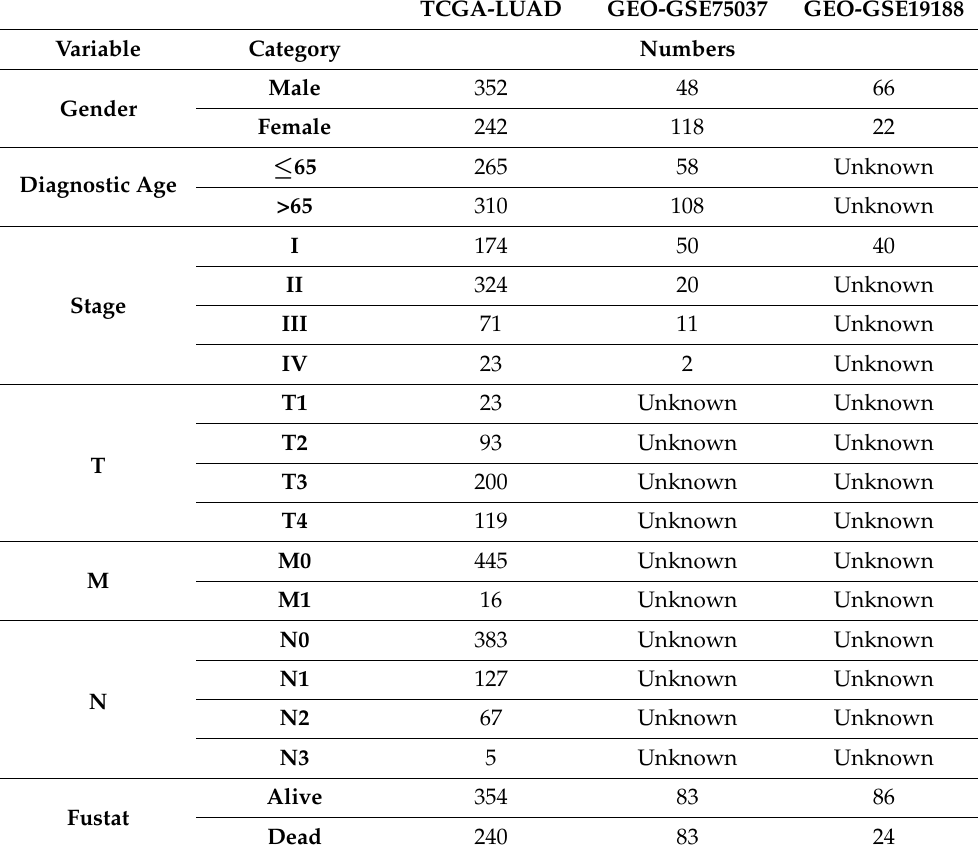
Table 1. Clinical